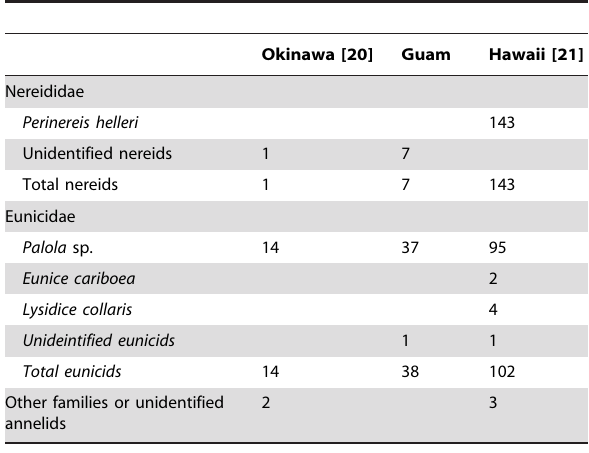
Table 3. Prey recovered from gut contents or feces of Conus ebraeus from locations in the Indo-West